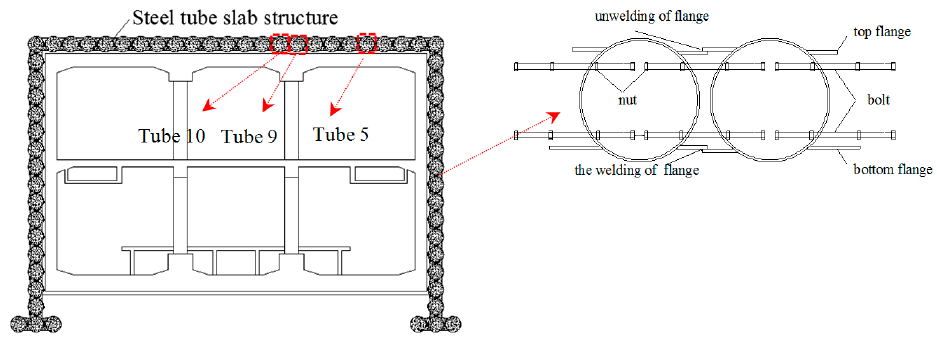
Figure 3. Steel Tube Slab system set-up.